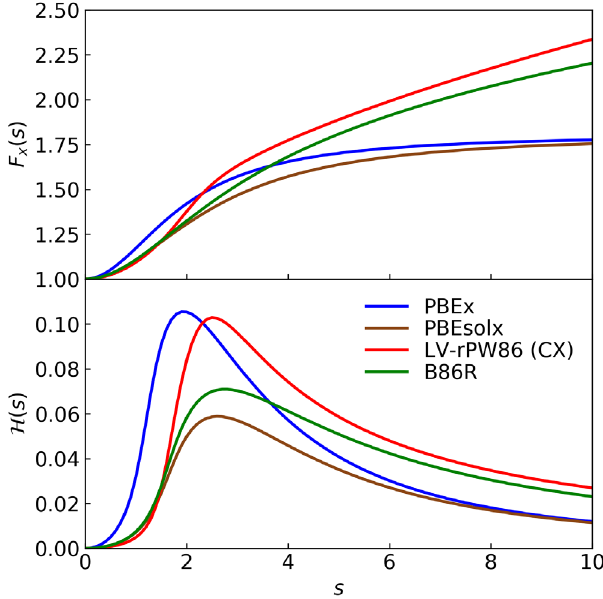
FIG. 2. Comparison of exchange-enhancement factor F x ð s Þ (top panel) and of the Gaussian-exponent prefactor H ð s Þ that determines the main damping in the AH modeling for the density-density correlation defining the underlying exchange holes